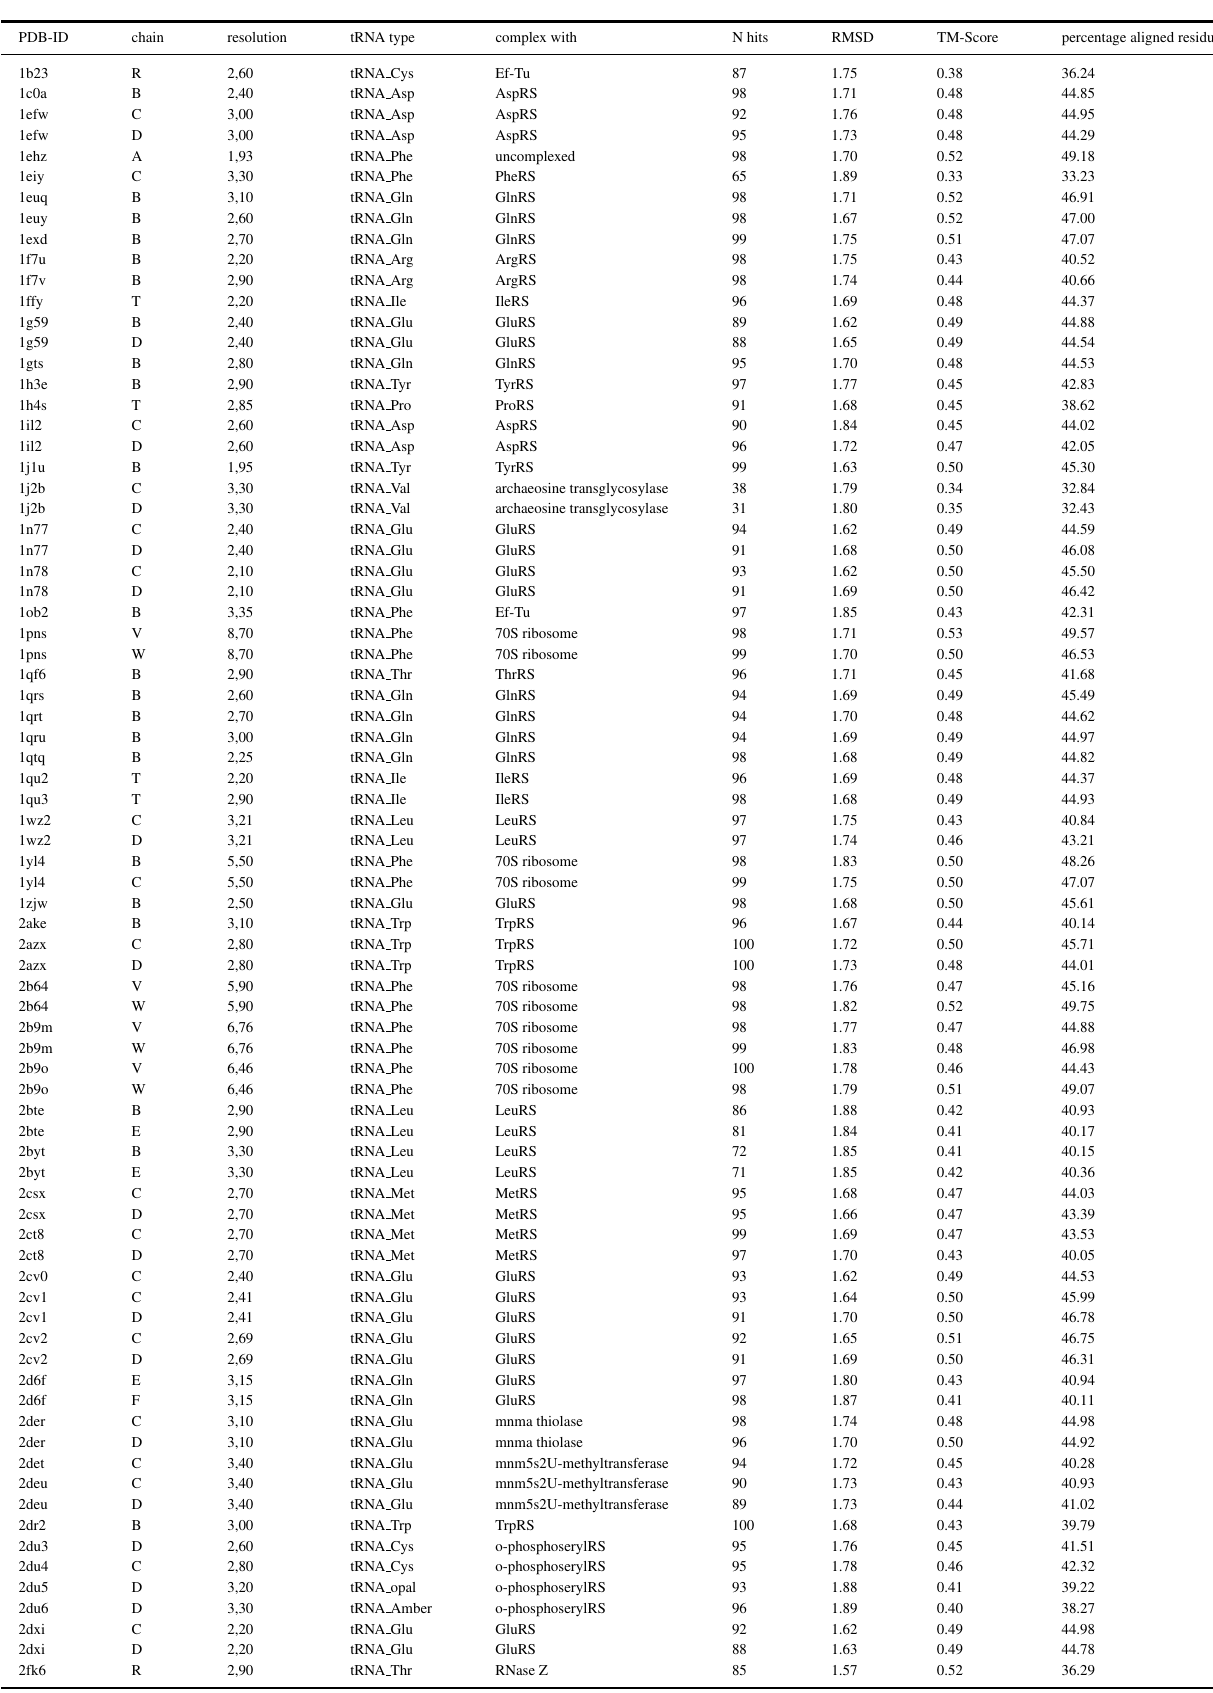
Table 1. tRNA search result table (part